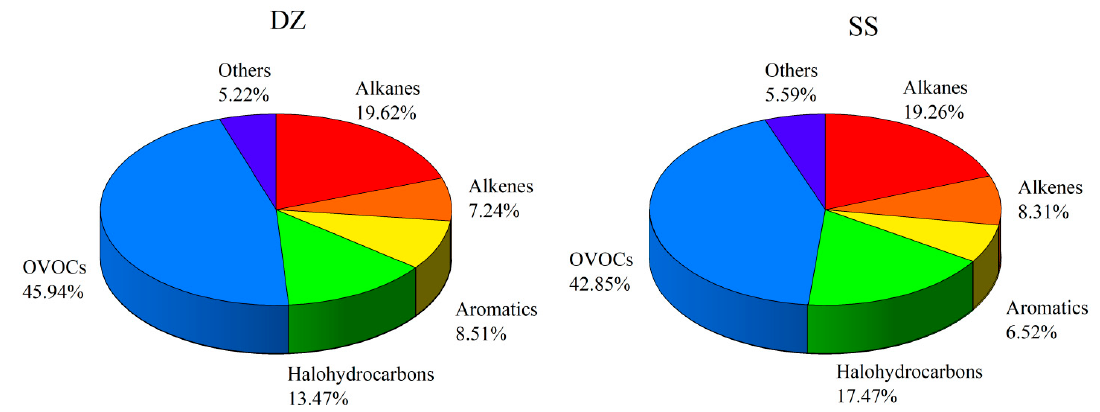
Figure 2. Composition of different groups of VOCs.